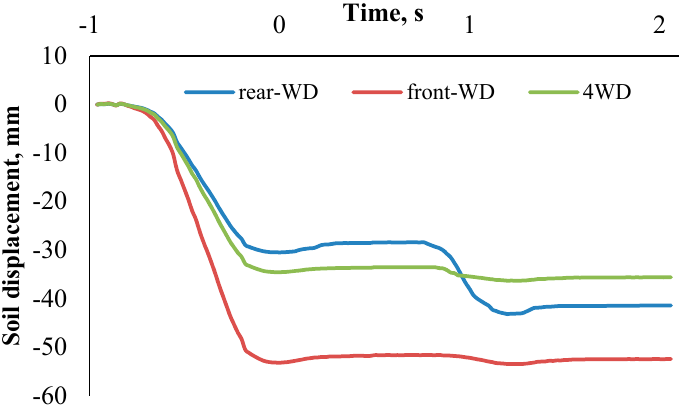
Figure 10. Soil strain along the vertical (z) direction.